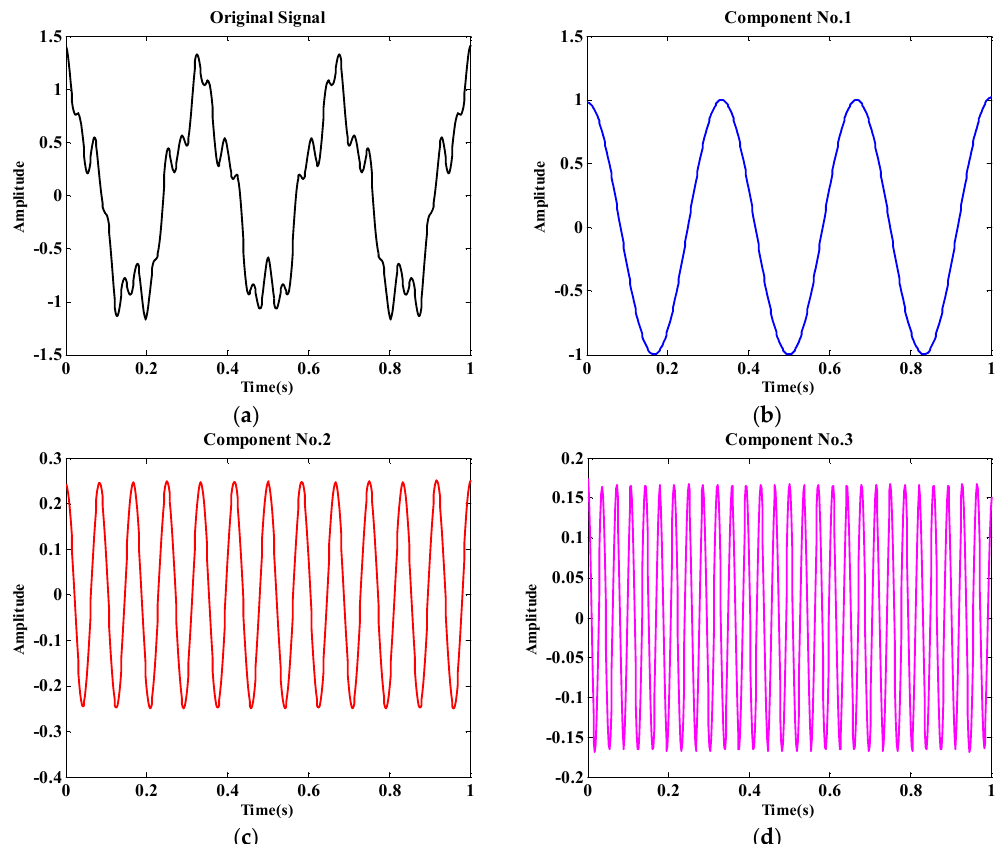
Figure A1. The decomposition result by VMD when K = 3 and α = 2500. ( a ) The original signal; ( b ) No. 1 mode component; ( c ) No. 2 mode component; ( d ) No. 3 mode component.